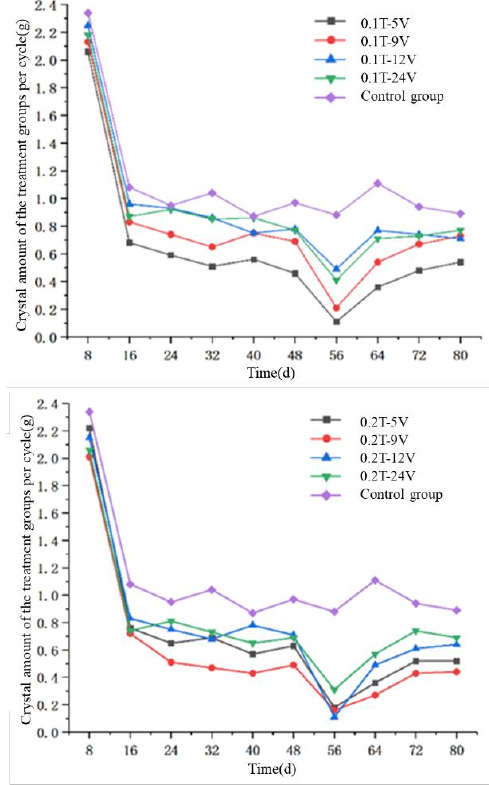
Fig. 10. Changes of the number of cumulative